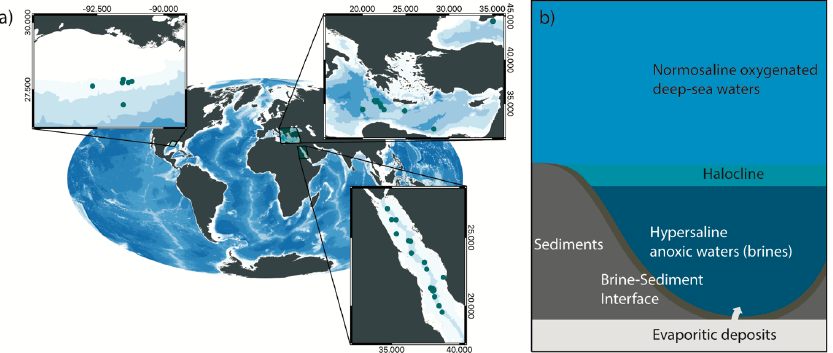
Figure 1. Locations of the DHABs identified in the Gulf of Mexico, Mediterranean Sea, Black Sea and the Red Sea ( a ) (for detailed elucidation on the environmental features and coordinates see [6]). Schematic vertical section of a generic DHAB showing the normo-saline oxygenated deep water, halocline and anoxic brines, brine-sediment interface and sediments ( b ).